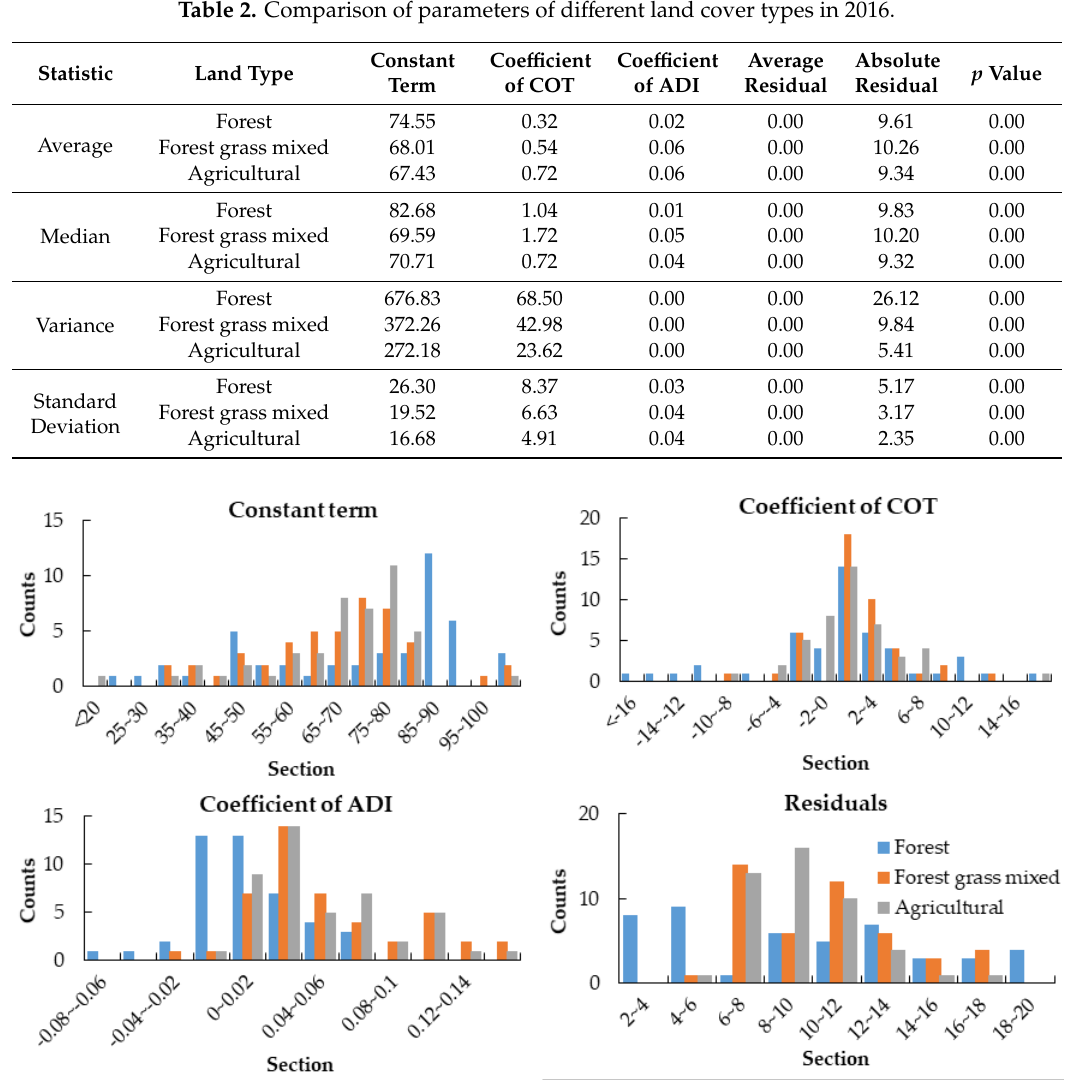
Figure 6. Histogram distribution of parameters of different land cover types in 2016.